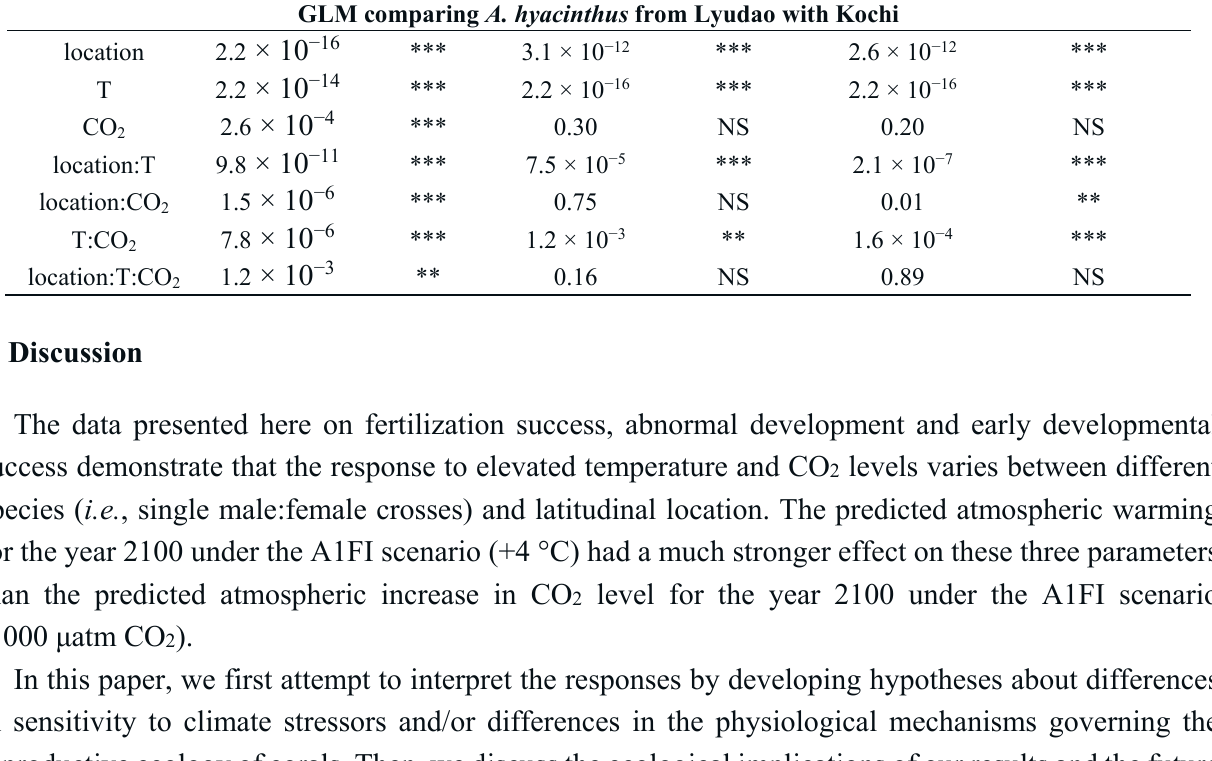
Table 3. Table showing a summary of the results of logistic regression using GLM for fertilization rate, abnormal development and early developmental success of the comparison between A. hyacinthus in Lyudao and Kochi. NS = not significant, * means p < 0.05, ** means <0.01 and *** means <0.001. See Table S3 for the Analysis of Deviance tables. Fertilization Success Abnormal Development Early Developmental Success p -Value p -Value p -Value GLM comparing A. hyacinthus from Lyudao with Kochi